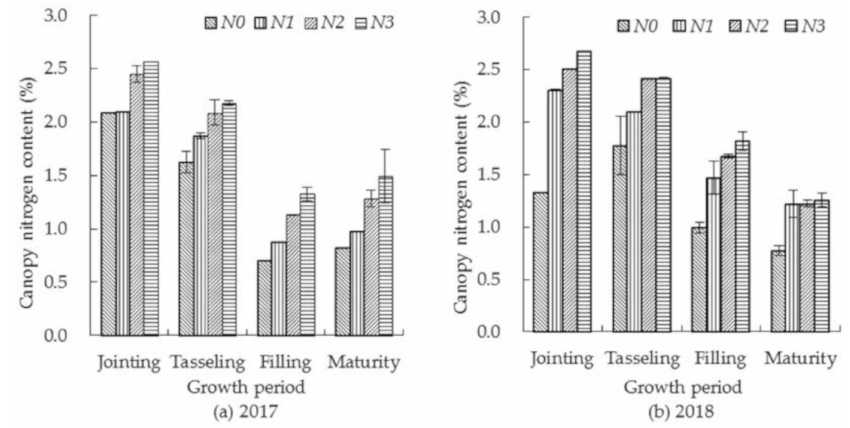
Figure 1. E ff ect of nitrogen application level on summer corn canopy nitrogen concentration.